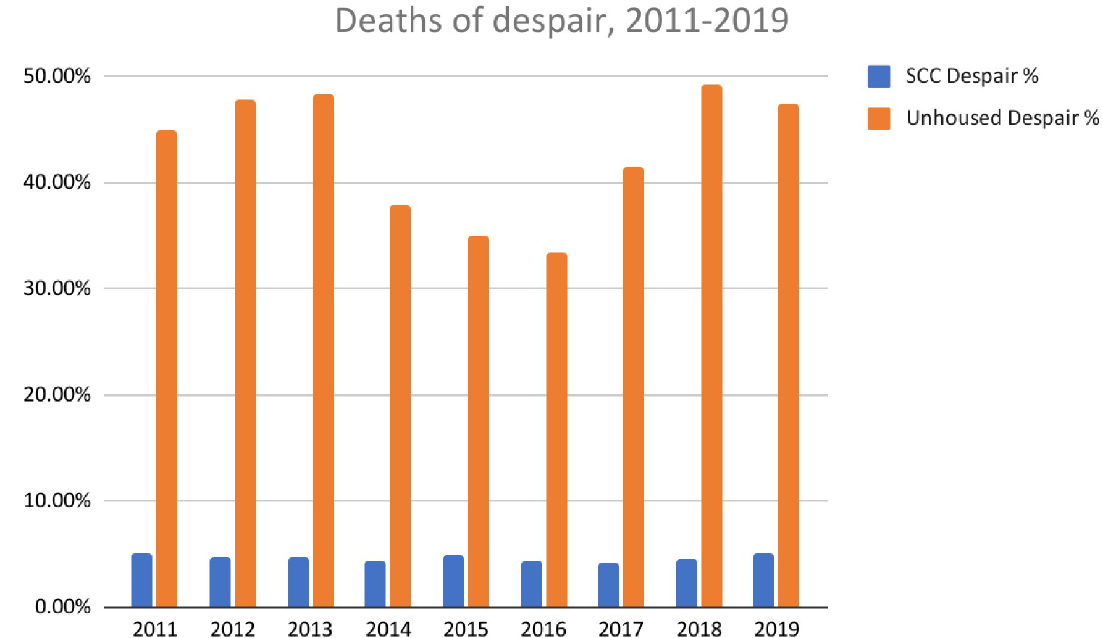
Fig 3. Proportions of deaths categorized as deaths of despair in the general population compared to the Santa Clara County (SCC) unhoused population between 2011–2019 (n = 88,658; 974 respectively).